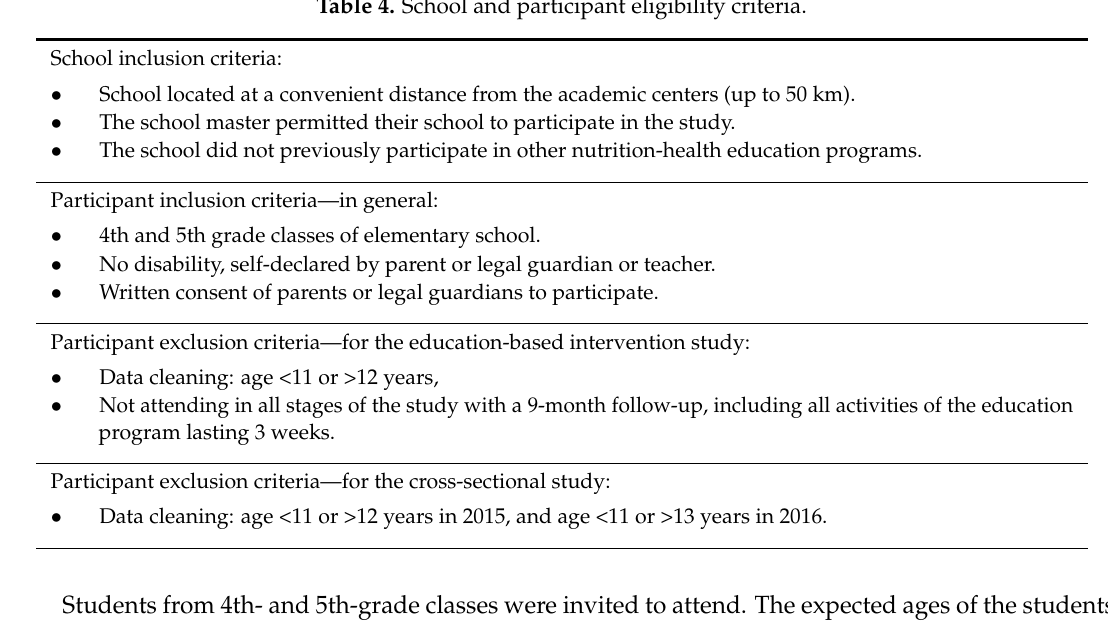
Table 4. School and participant eligibility